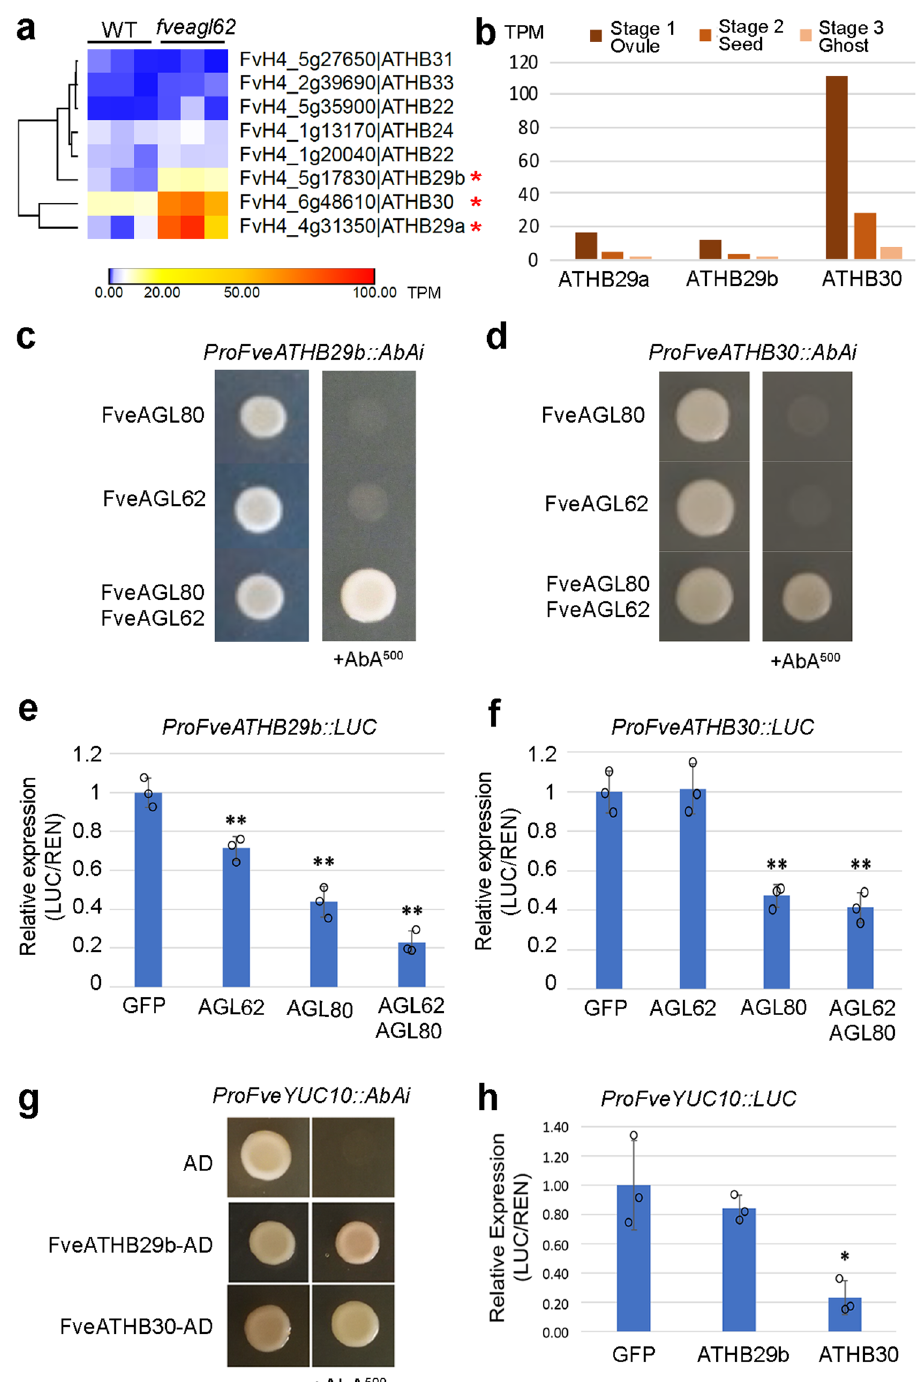
Fig. 5 FveAGL62/FveAGL80 regulates a family of FveATHB genes in strawberry. a Hierarchical clustering heatmap showing RNA-seq reads (TPM) in WT and fveagl62 mutant seeds at stage 2 for a subclass of FveATHB genes. Three FveATHB genes (marked by *) are more highly expressed in the fveagl62 mutant seeds than the WT. b Bar graphs showing the expression level (TPM) of three FveATHB genes at the stage 1 ovules, stage 2 seeds, and stage 3 ghosts in WT based on a prior RNA-seq dataset 5 . c , d Y1H assays showing binding and activation of promoters of FveATHB29b and FveATHB30 by the combined action of FveAGL62 and FveAGL80. e , f Transient repression of the LUC reporter driven by the FveATHB29b ( e ) or FveATHB30 ( f ) promoter. Effector proteins are FveAGL62 or FveAGL80 alone or in combination. Signi fi cant difference from the negative control (GFP) is marked by ** ( P < 0.01 by two-tailed Student ’ s t -test). Error bars indicate standard deviation. Three biologically independent experiments gave similar results. g Y1H assay testing the binding of FveATHBs to ProFveYUC10::AbAi in the SD-Leu-Ura medium with or without 500 ng/ml AbA. Empty vector containing the AD serves as a negative control. h Transient repression of ProFveYUC10::LUC in tobacco leaves. Y-axis indicates the relative expression level of LUC compared to REN. Signi fi cant difference from the negative control (GFP) is marked by * ( P < 0.05 by two-tailed Student ’ s t -test). Error bars indicate standard deviation. Three biologically independent experiments gave similar